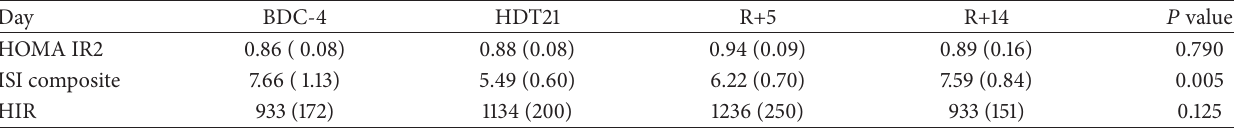
Table 1: Mean values (SEM) of insulin resistance and insulin sensitivity